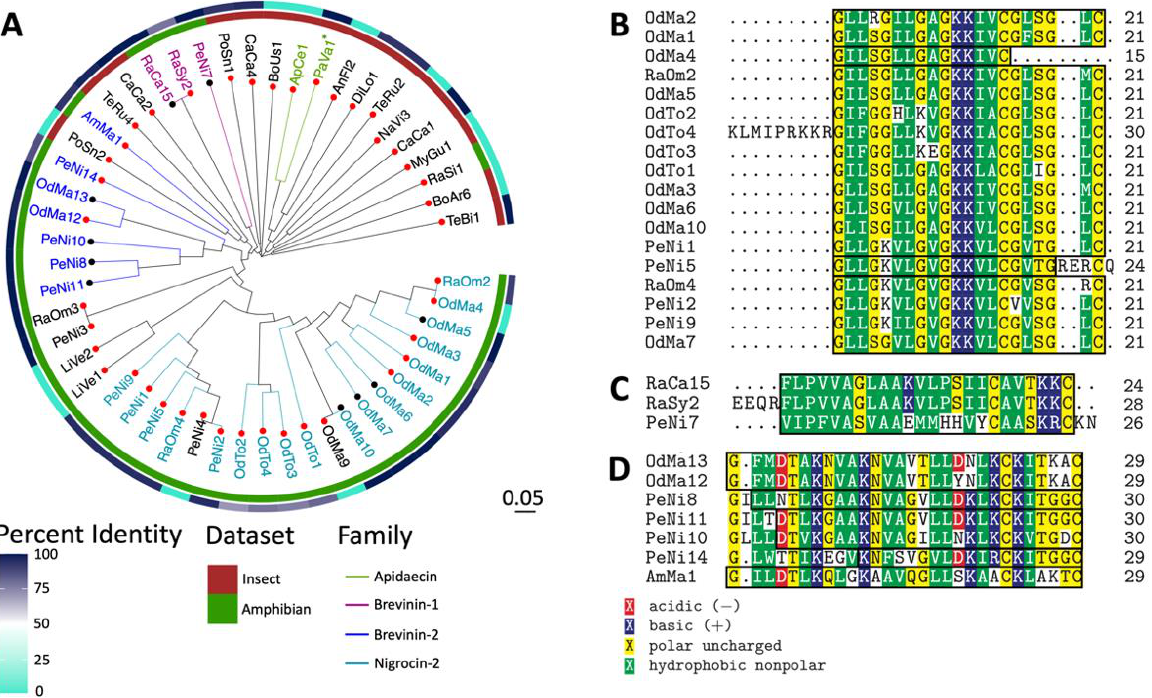
Figure 3. Phylogenetic analysis of validated AMPs. ( A ) Circular phylogenetic tree based on a multiple sequence alignment of active rAMPage peptides with family classifications highlighted (colour-coded AMP names). The origin of AMP (insects in brown and amphibian in green) and BLASTp percent identity to entries in the NCBI non-redundant protein database (on a scale of 0–100%) are indicated by the inner and outer rings, respectively. Tip points of peptides that do not have 100% sequence identity to the bioactive region of known AMPs are highlighted in red. Multiple sequence alignments of the Nigrocin-2 ( B ), Brevinin-1 ( C ) and Brevinin-2 families ( D ), with the outlines indicating the identified family